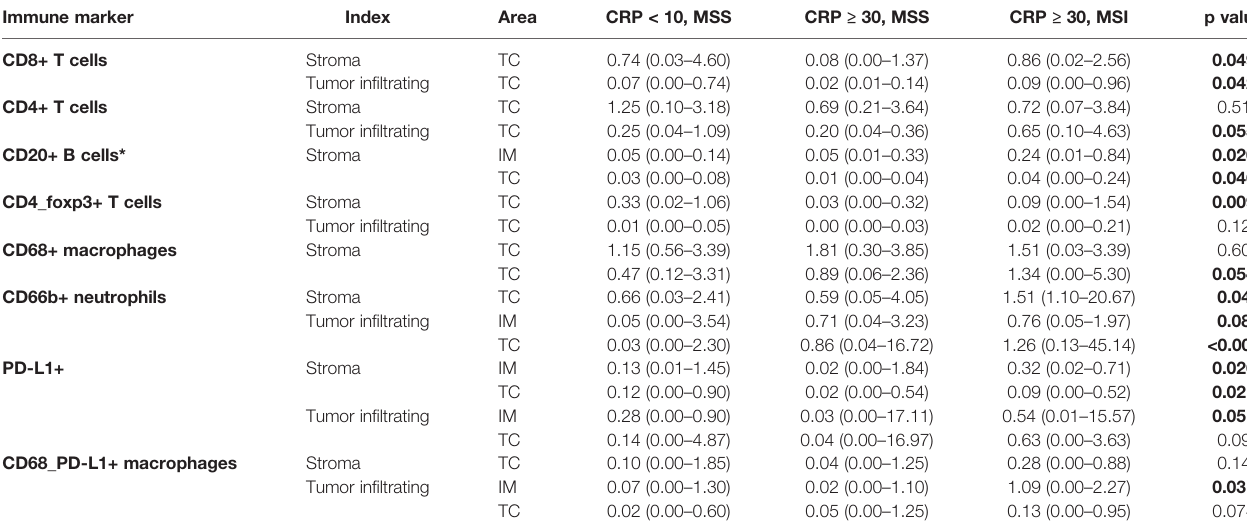
Immune markers in percent, median (range). p-values were obtained using the Kruskal – Wallis test. IM, invasive margin; TC, tumor center. *CD20+ B cells were in fi ltrating the stroma only. Bolded values indicate statistical signi fi cant